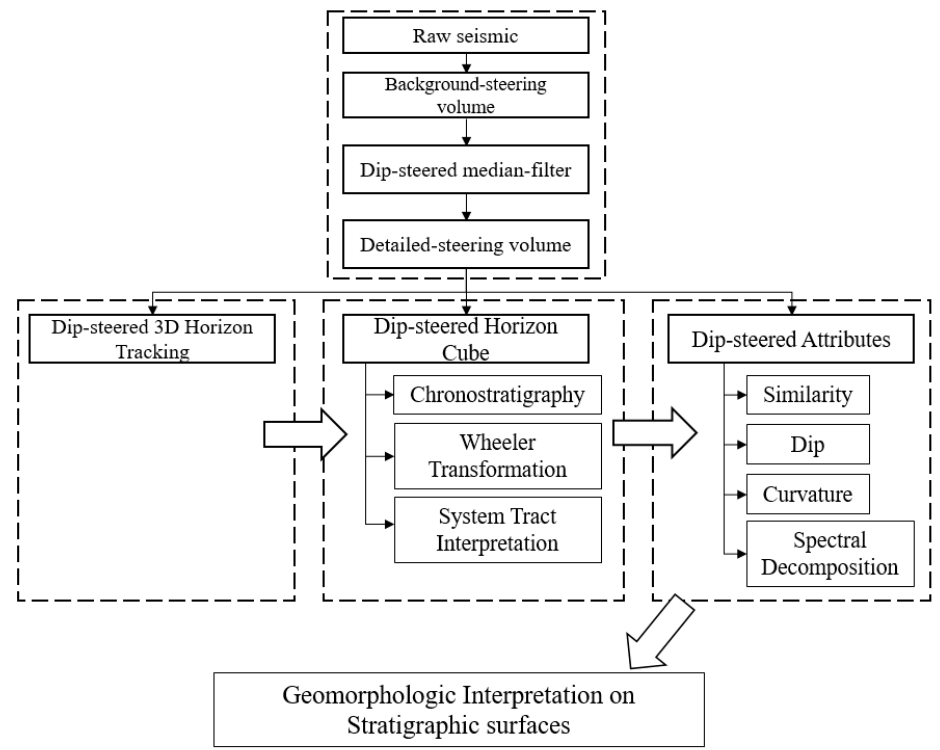
Figure 7. The workflow for the structural and stratigraphic interpretation applied to the seismic data.